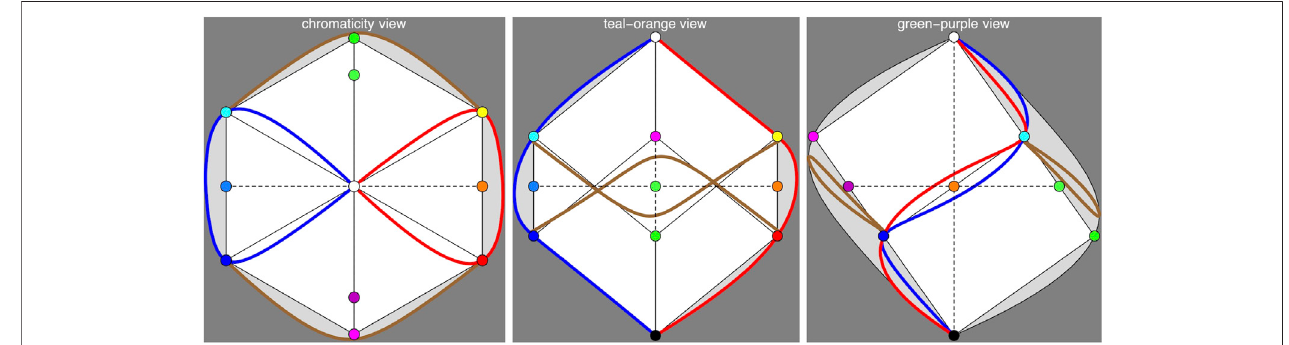
FIGURE 9 | The “ chromaticity diagram ” introduced in this fi gure is a view of the color solid from ∞ along the KW – Hering axis. A complete graphical representation adds views along the TO – and GP – Hering axes. The “ teal – orange view ” is a projection in the green – purple direction on the KW – TO – plane, the “ green – purple view ” is a projectionintheteal – orangedirectionontheKW – PG – plane.Theseviewsexplicitlydepictchromaticity,spectral slopeandspectralcurvaturemodulations. Indicatedare the RGB – cube, the cool and warm edge colors (blue and red), the semichromes (brown) and the teal ( RGB [ 00 | 50 | 99 ]) , orange ( RGB [ 99 | 50 | 00 ]) ,